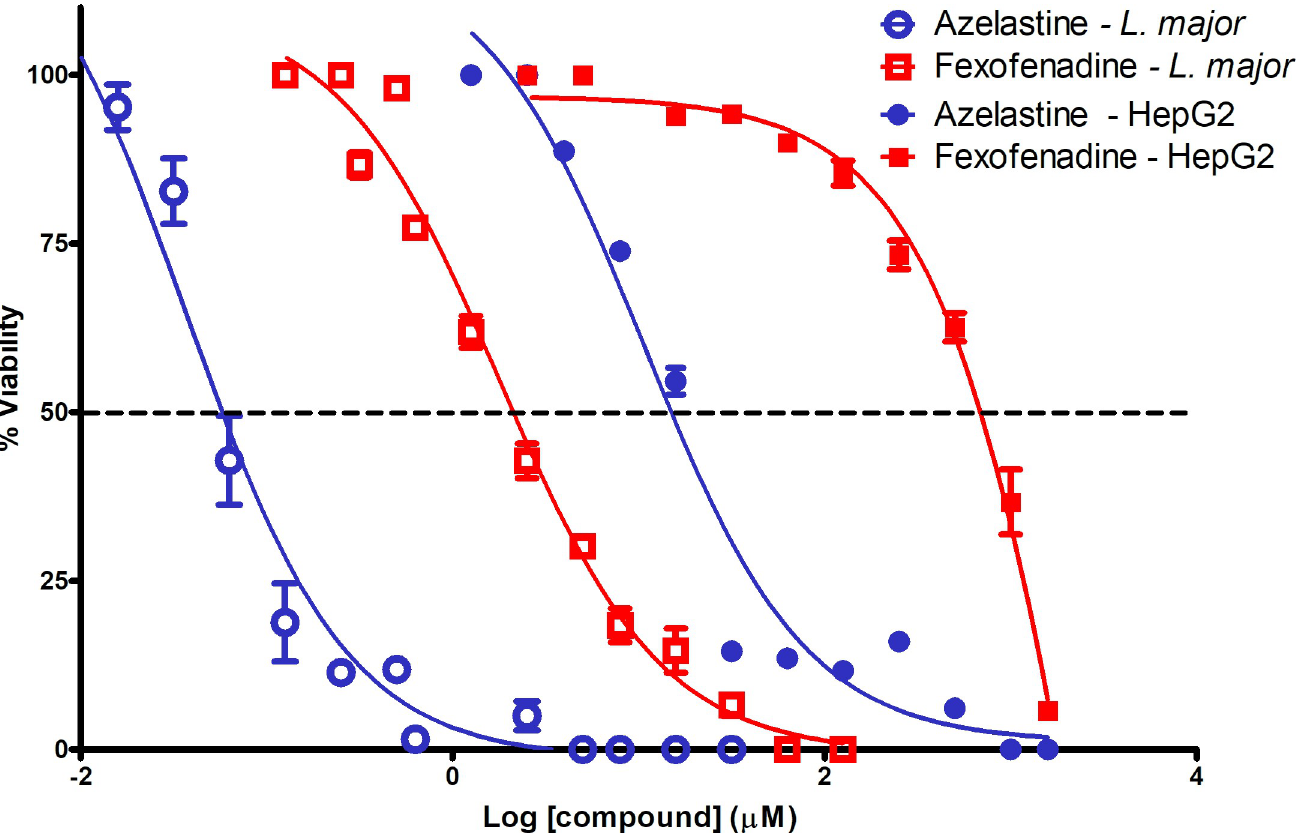
Fig 2. Anti-leishmanial efficacy (EC 50 ) versus cytotoxicity (CC 50 ) for determining the in vitro therapeutic index of azelastine and fexofenadine. The EC 50 was determined in the ex vivo system while the CC 50 was assessed using HepG2 cells.